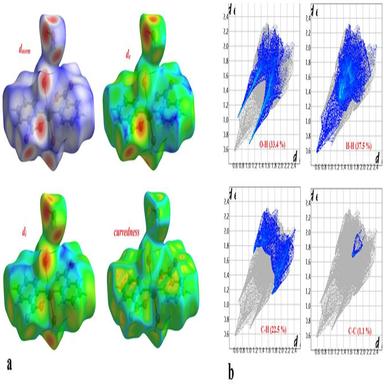
(a) Hirshfeld surfaces for dnorm, di , de and curvedness for the PCOH molecule and (b) 2D finger print plots showing various intermolecular contacts in the PCOH.